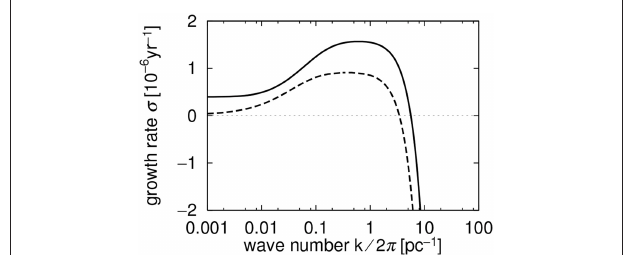
FIGURE 2 | The dispersion relation for condensation mode of thermal instability analyzed in Koyama and Inutsuka (2000). The dashed curve denotes the classical result for the case of thermal equilibrium unperturbed state. The solid curve denotes for the case of an isobarically contracting unperturbed state. Reproduced from Koyama and Inutsuka (2000) with permission of ApJ.